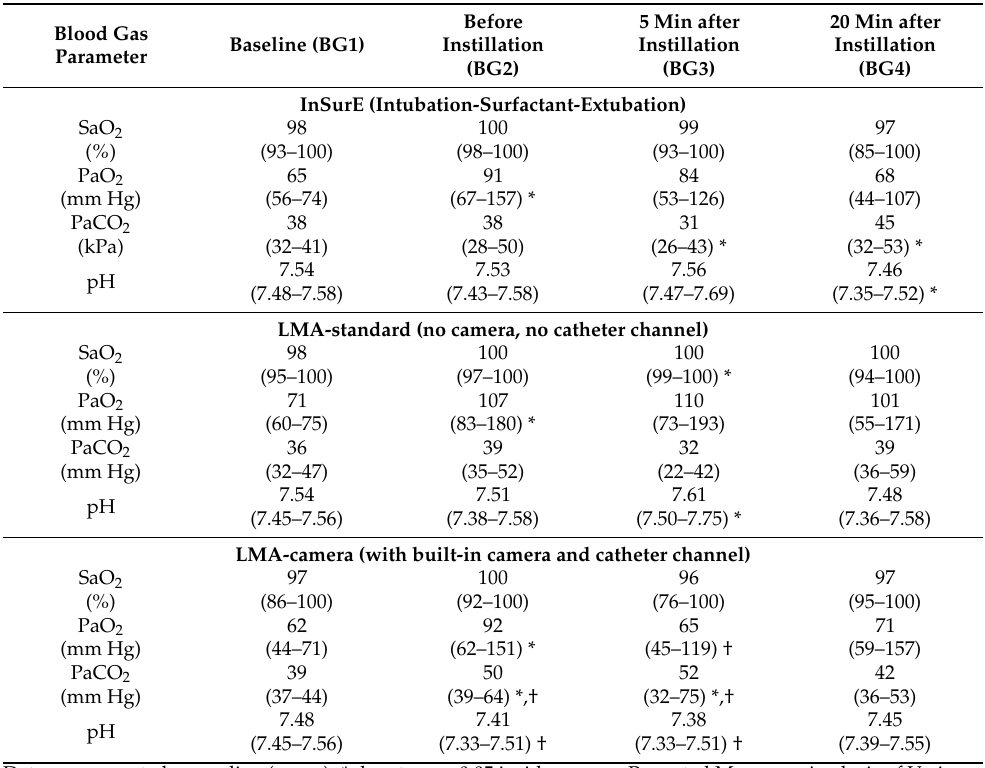
Table 1. Blood gases.